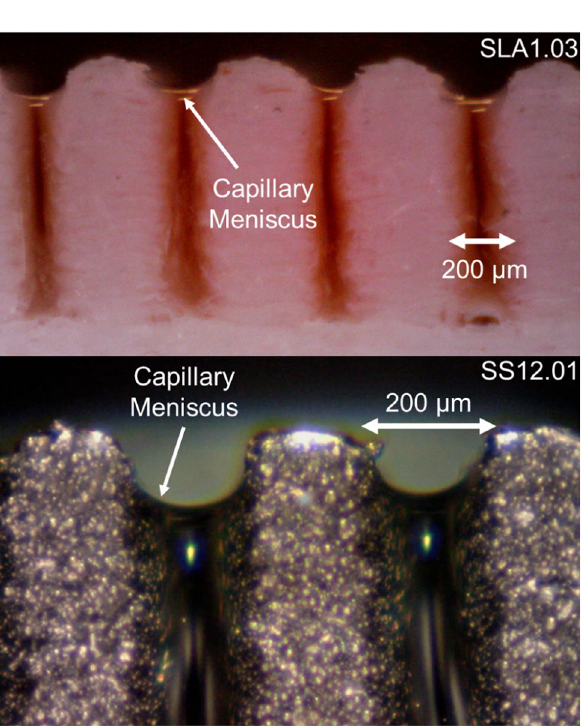
Figure 11. A capillary meniscus is formed between two adjacent micro-grooves due to the disjoining pressure. Top: SLA1.03, Bottom: SS12.01. A 1% solution of water and food coloring is used for better image contrast in the polymer sample. Table 1 lists the sample